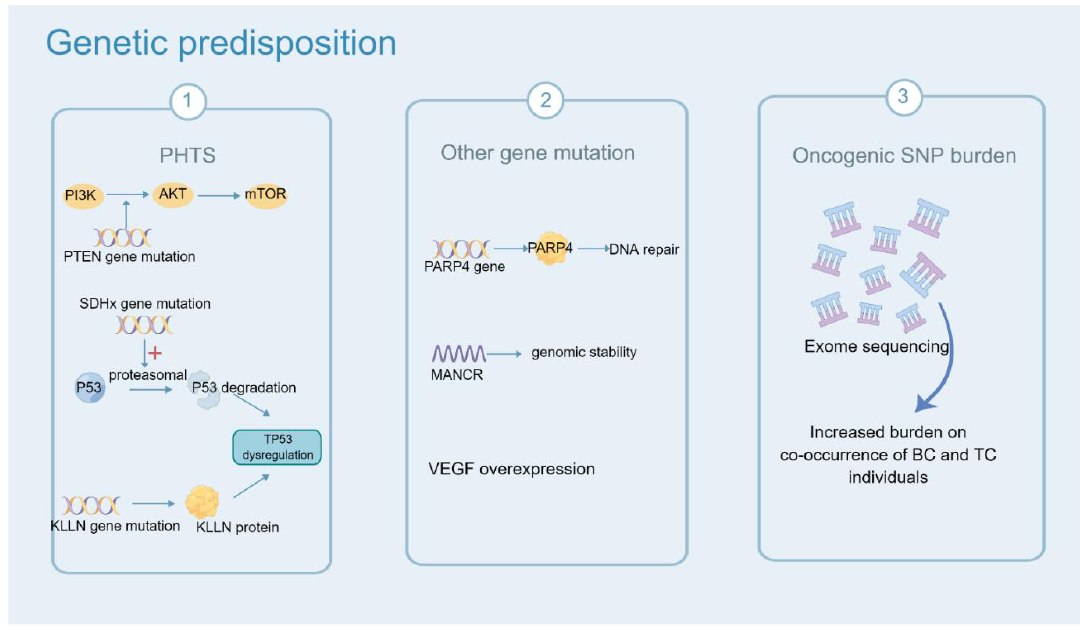
Figure 4. Summary of genetic susceptibility of BC and TC. In part 1, PTEN hamartoma tumor syndrome (PHTS, comprising Cowden, Bannayan-Riley-Ruvalcaba, and Proteus-like syndromes) is due to germline mutations of tumor suppressor gene: phosphatase and tensin homolog (PTEN). The gene mutation of PTEN upregulates the PI3K-AKT pathway. SDHx (the succinate dehydrogenase complex) mutations can dysregulate TP53 by upregulating p53 proteasomal. KLLN gene encodes the KLLN protein, which is a transcription factor. KLLN mutation influences TP53 dysregulation. In part 2, PARP4 gene encodes poly-ADP-ribose polymerases (PARPs) and is an important compo- nent of DNA repair. MANCR (mitotically-associated long noncoding RNA) is an important regula- tor of the genomic stability of aggressive breast cancer. The vascular endothelial growth factor (VEGF) was overexpressed in TC and BC. In part 3, increased oncogenic single nucleotide polymor- phism (SNP) burden in co-occurrence of BC and TC.